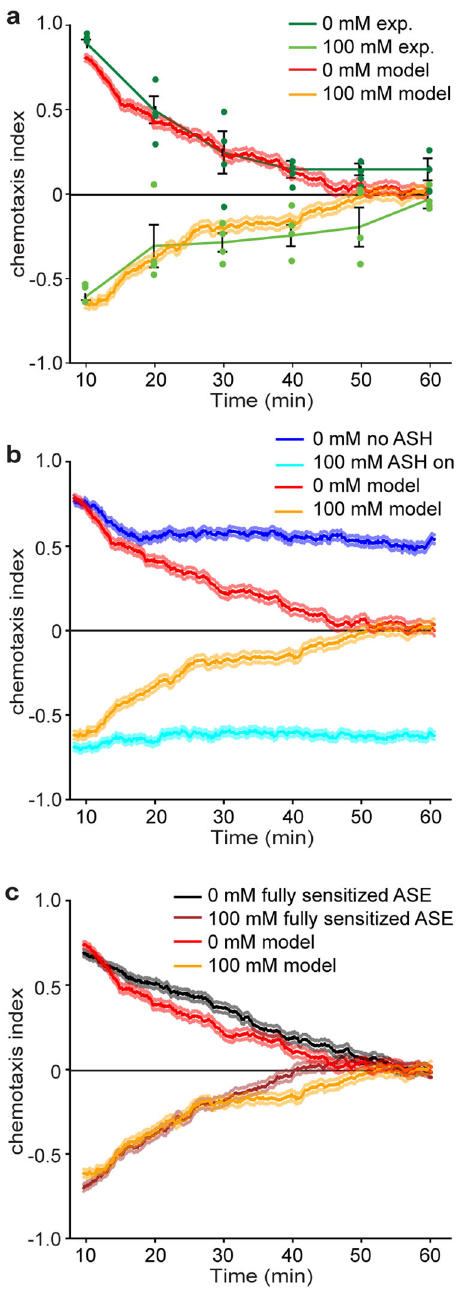
Fig. 8 Stochastic recruitment of ASH drives gustatory plasticity in our computational model. Chemotaxis index over time in experiments and simulations of the quadrant assay. a Average chemotaxis index (±SEM, individual data points have been indicated as dots) of naïve (0 mM) and pre-exposed (15 min, 100 mM NaCl) animals ( n = 4 independent assays). The behavioral results (green) and the modeling results (red, orange) show a monotonic decay towards a chemotaxis index of 0, for both naïve and pre-exposed animals. b Virtual chemotaxis index for animals with unrecruited ASH (dark blue) and with recruited ASH (light blue). Without ASH state dynamics the chemotaxis index does not decay to 0. c Comparison of chemotaxis index for model with ASE (de) sensitization (red, orange) and with fully sensitized ASEL and ASER (black, brown). Source data underlying this fi gure are available in Supplementary Data